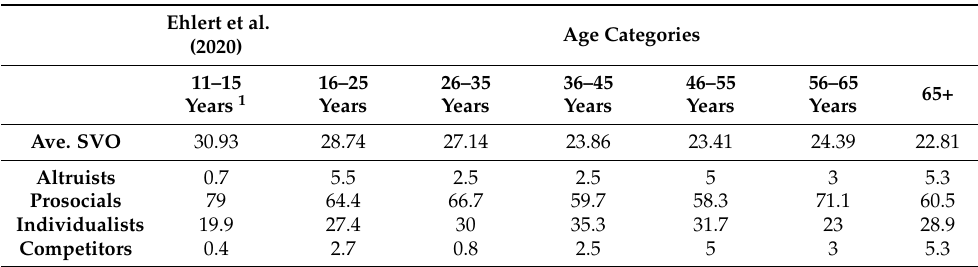
Table 2. Average Social Value Orientation (SVO) and percentage of altruists, prosocials, individualists, and competitors for differing age groups and differing studies